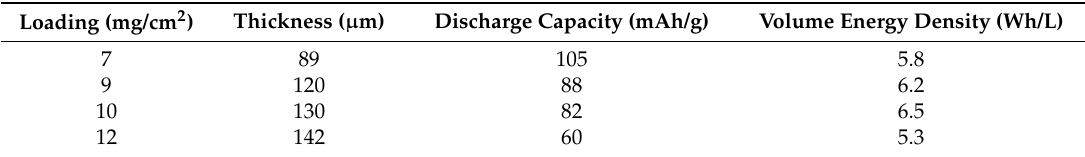
Figure 4. ( a ) Electrochemistry impedance spectra (EIS) curves with graphite loading; and ( b ) relationship between Z” and ω − 1/2 of the related EIS plots. The EIS measurement of the Al batteries was analyzed under charging at 2.5 V. Table 2. Thickness, discharge capacity, and calculated volume energy density of loading graphite electrode at a charge–discharge current density of 100 mA/g.